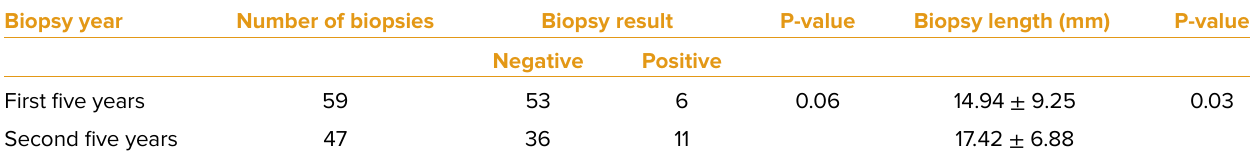
Table 3. Comparison of the first and second five years in terms of biopsy result and length Biopsy